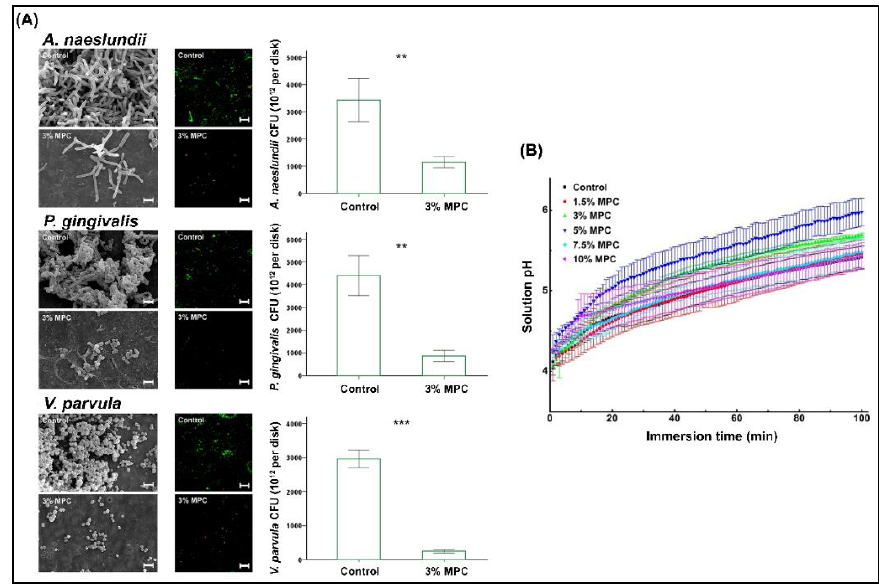
Figure 5. ( A ) Enhanced resistance to bacterial adherence against early and late colonizers with 3% MPC and ( B ) trend in the pH changes observed with different percentages of MPC. MPC—2-methacryloyloxyethyl phosphorylcholine. ** p < 0.01, *** p < 0.001. Reproduced with permission from Lee et al. [52]; published by Elsevier, 2019.